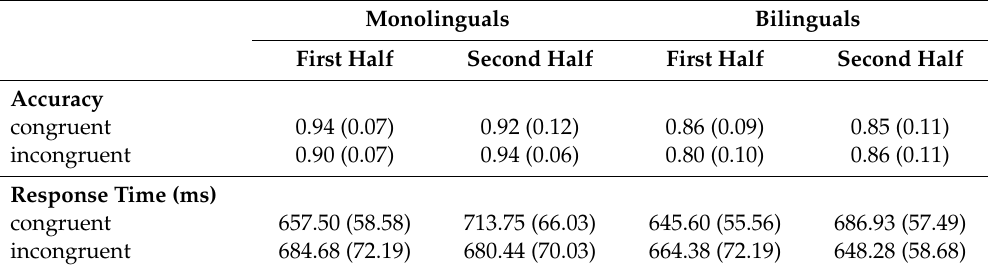
Table 3. Mean and standard deviation for Stroop performance by experimental